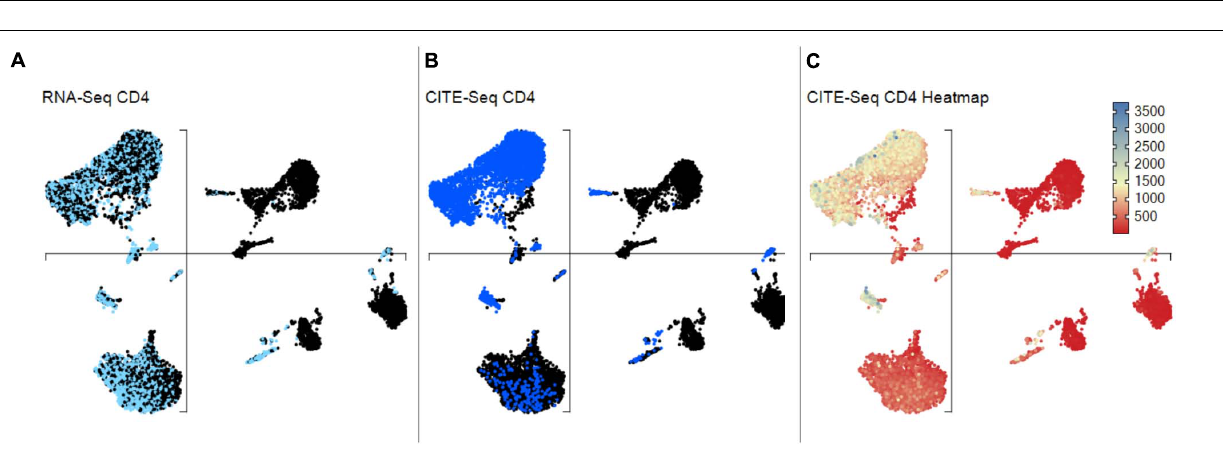
FIGURE 12 | scCITEseq data visualization on scRNA-defined UMAP. Gene and corresponding surface protein expression can be compared across individual cells on the same unsupervised UMAP. (A) Cells highlighted with scRNA-seq defined positive CD4 expression. (B) Cells highlighted with surface CD4 expression